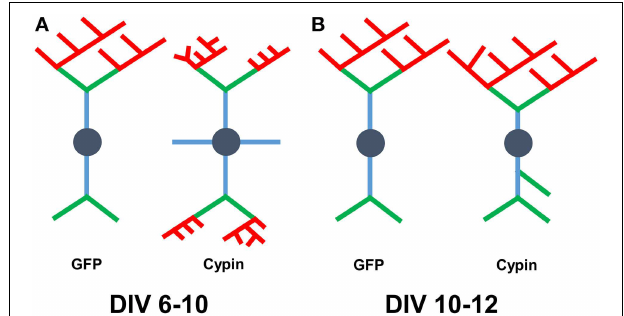
FIGURE 10 | Schematic of results when combining analysis using all three labeling schemes. (A) Changes that occur to the arbor as a result of cypin overexpression from DIV 6–10. Overexpression of cypin increases primary dendrite numbers (blue) and tertiary and higher order dendrite numbers (red). Overexpression of cypin also increases intermediate dendrite numbers (green and red) and terminal dendrite numbers (green and red) but not secondary dendrite numbers (green). Overexpression of cypin decreases tertiary and higher order dendrite length, intermediate dendrite length, and terminal dendrite length but does not affect primary or secondary dendrite length. (B) Changes that occur to the arbor as a result of cypin overexpression from DIV 10–12. Overexpression of cypin increases primary dendrites as labeled by Tips-In (terminal dendrites, green and red) and secondary dendrites as labeled by Tips-In (intermediate or root dendrites, green, and blue). Overexpression of cypin significantly decreases tertiary and higher order dendrite length as labeled by Tips-In (root dendrites that branch twice or more). For schematics shown in (A,B) , dendrites are labeled according to the Inside-Out (conventional)